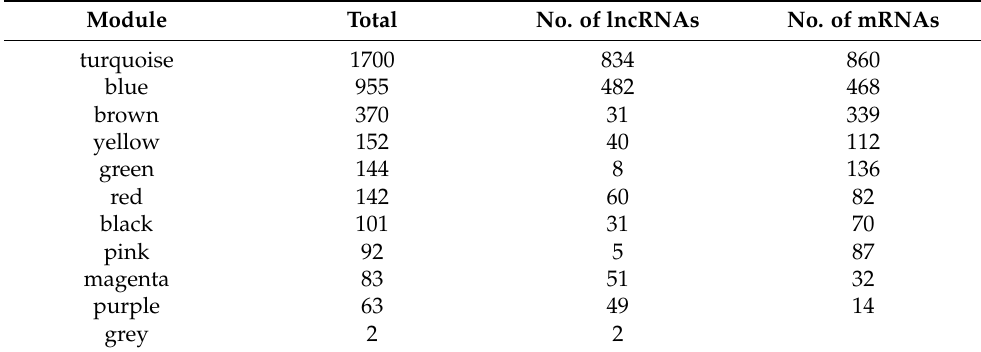
Figure 2. WGCNA was used to identify trait-related modules and genes. ( a ) Scale independence and mean connectivity analysis for various soft threshold powers. ( b ) Clustering dendrograms of lncRNAs and mRNAs. The color bands provide a simple visual comparison of module assignments based on the dynamic tree cutting method. WGCNA, weighted correlation network analysis. Table 1. The number of lncRNAs and mRNAs in the 11 modules.